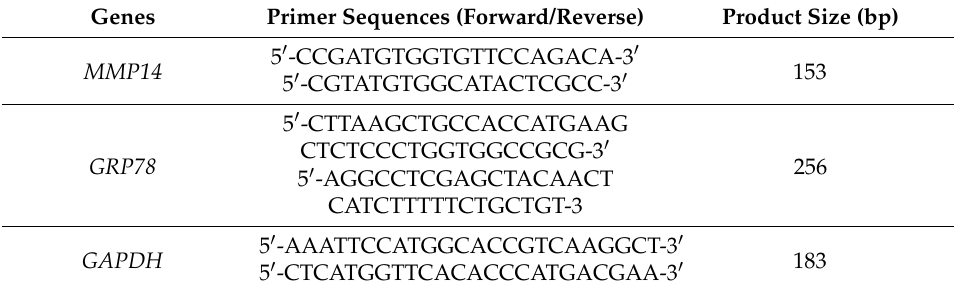
Table 1. Primer sequences for real-time